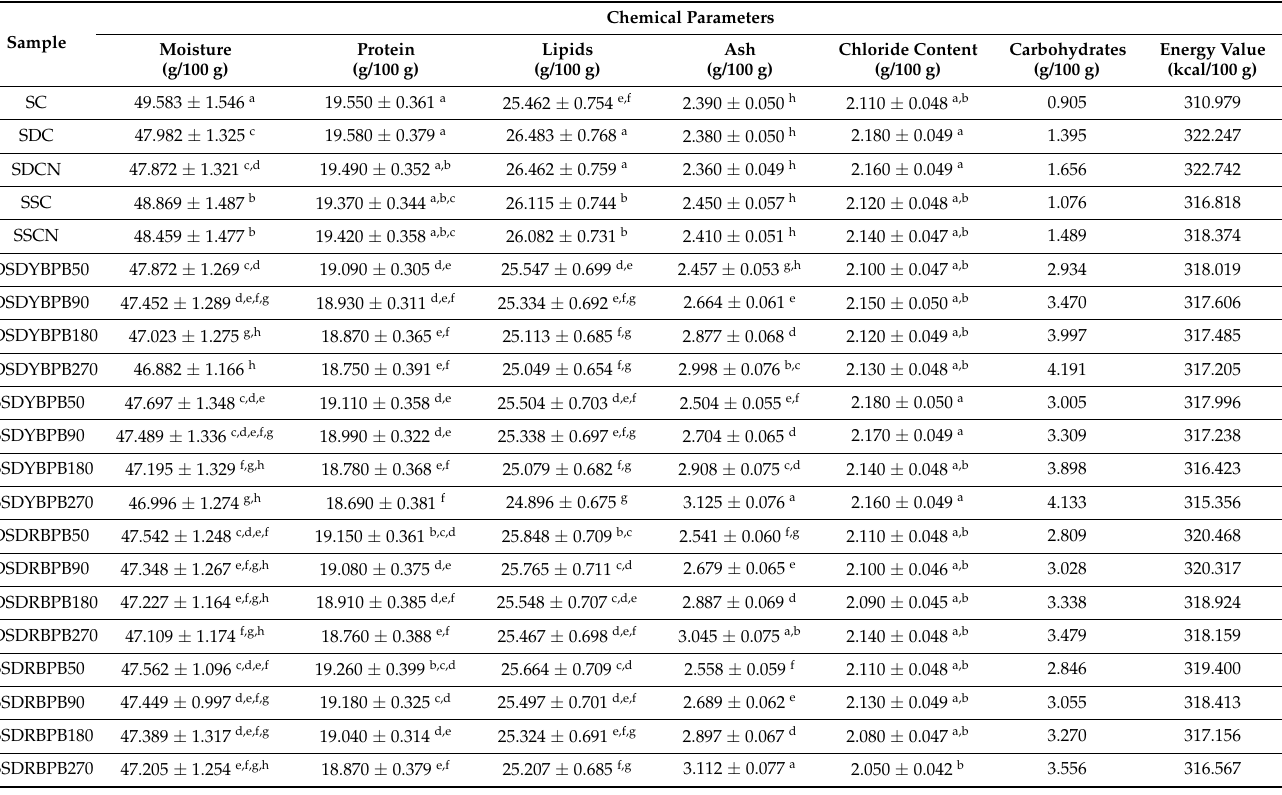
Table 3. Proximate composition of sausage